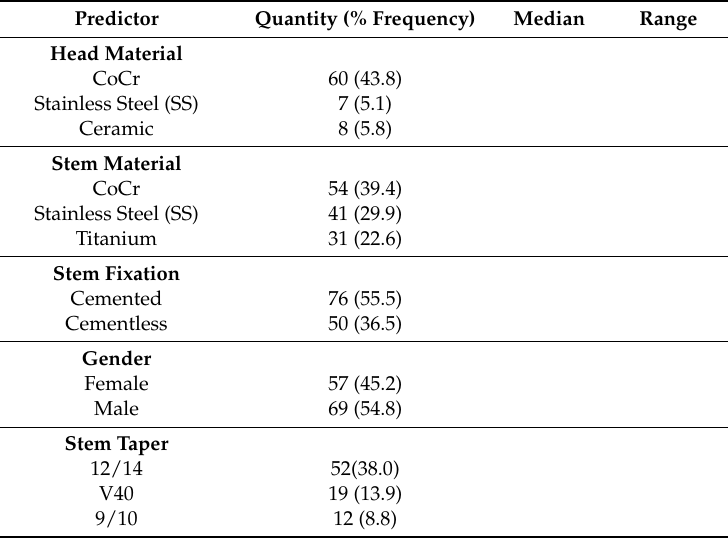
Table 1. Demographics of the selected retrievals for this